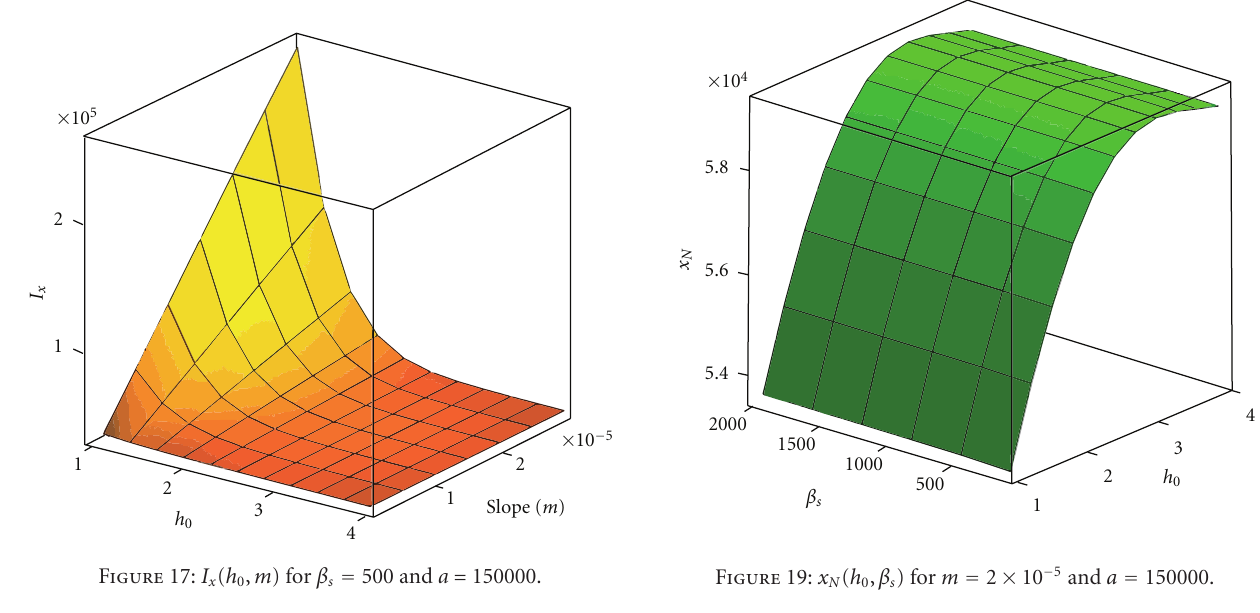
Figure 16: I x ( h 0 , β s ) for m = 2 × 10 − 5 and a = 150000.